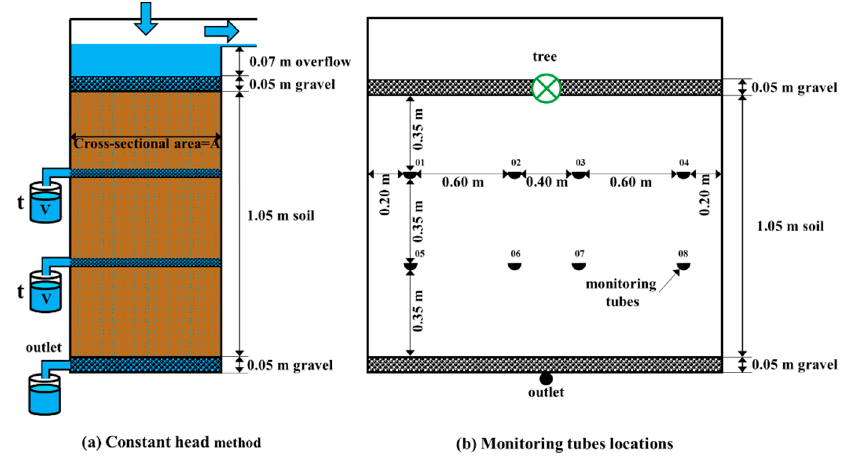
Figure 3. Schematic view of ( a ) the constant-head monitoring method experimental setup, showing the position of ( b ) the horizontal monitoring tubes.( V is the volume of the measuring vessel/container and t is the time (in days, converted from recorded minutes) taken for the vessel to be filled with water running from each horizontal monitoring tube)